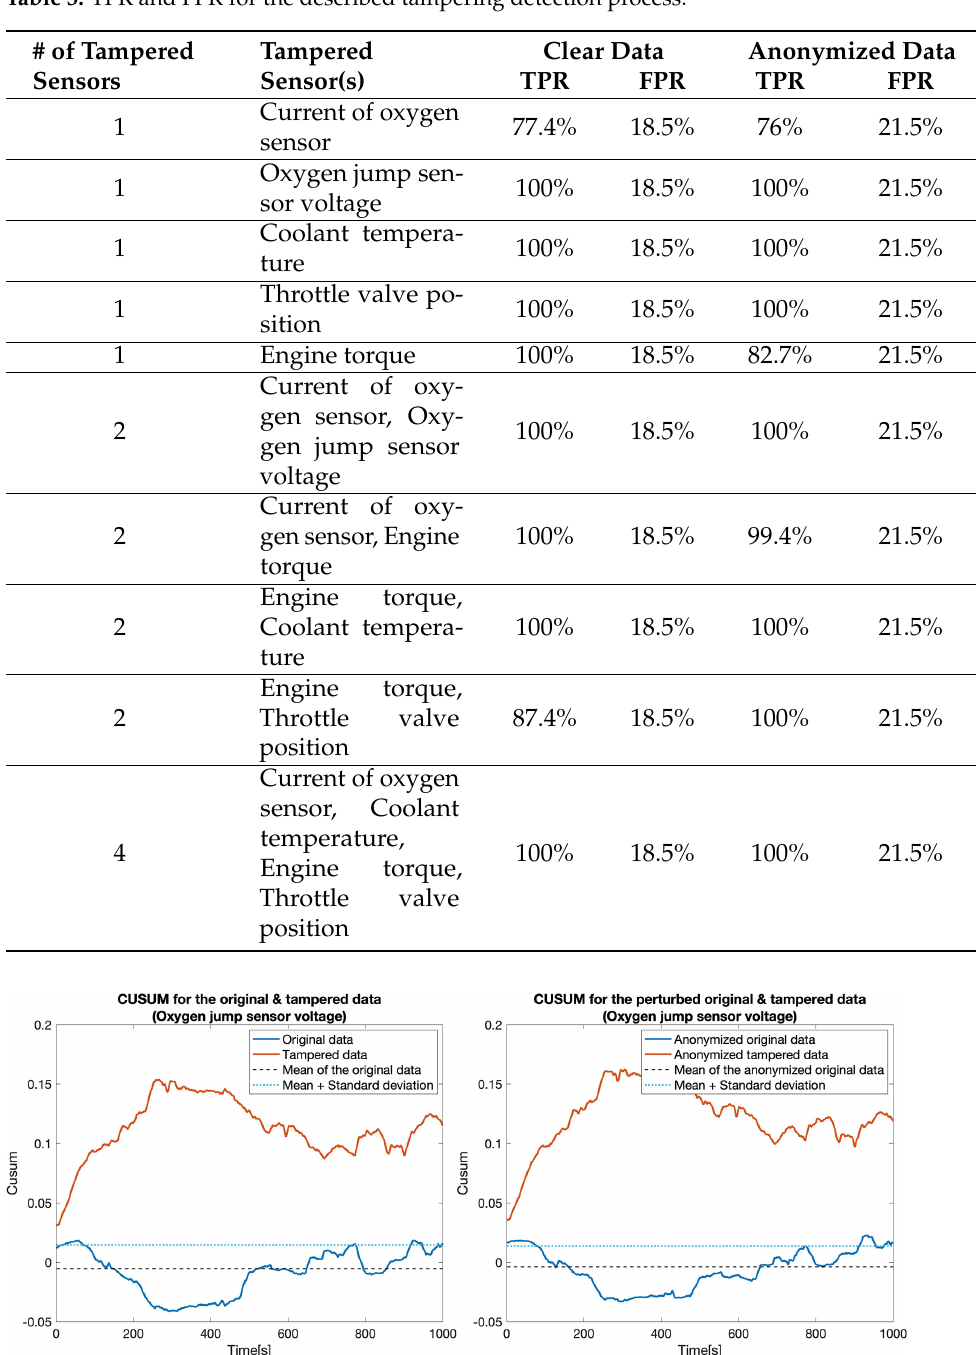
Figure 6. CUSUM for the original data (blue) and tampered data (orange) for the Oxygen jump sensor voltage